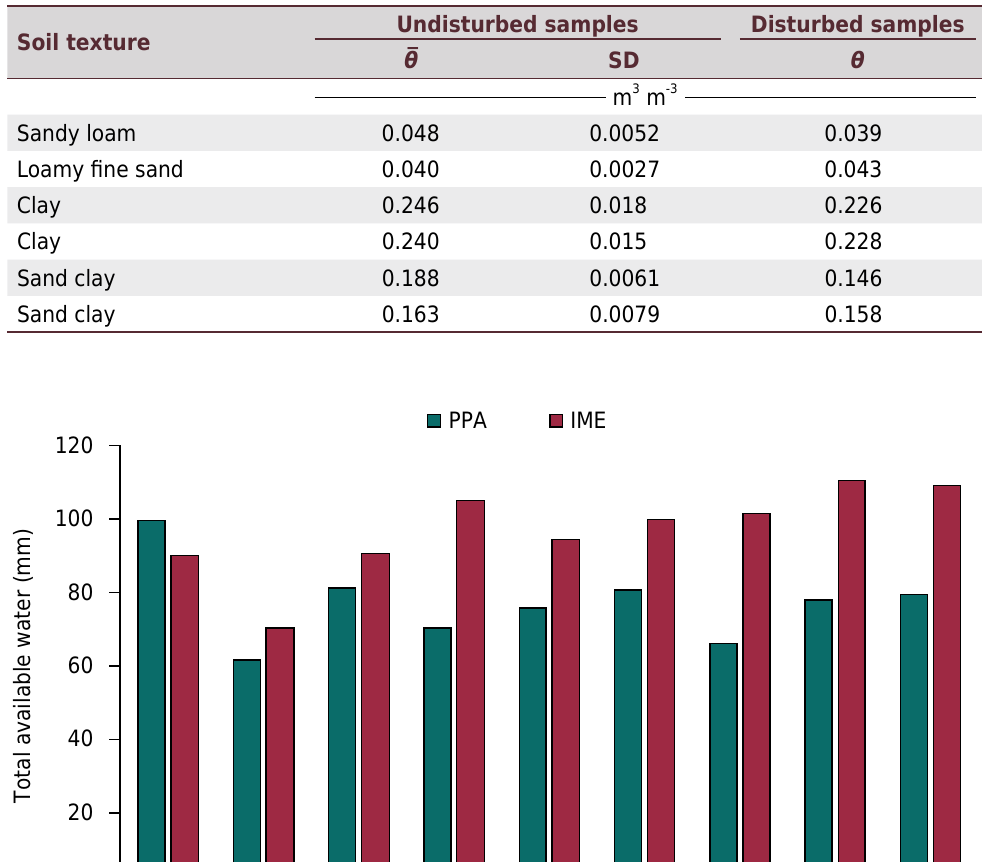
Table 3. Average soil water content (from 5 replicates) with its standard deviation (SD) attained at pressure head -150 m for undisturbed samples equilibrated in the PPA, together with individual